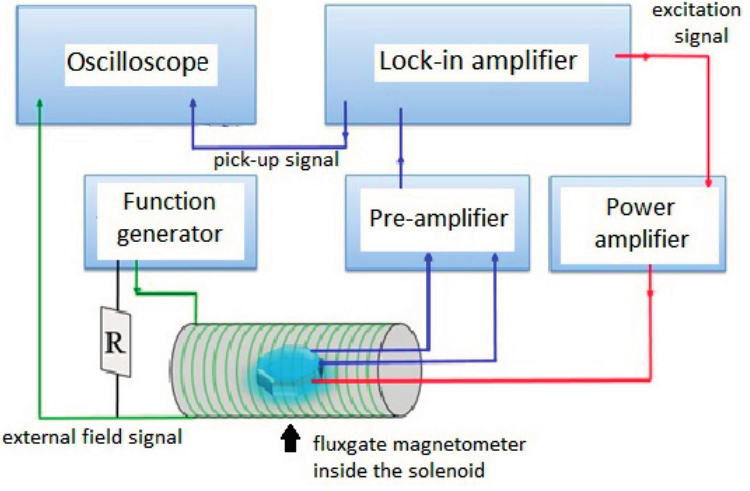
Figure 8. A schematic diagram of the fluxgate magnetometer setup for characterization